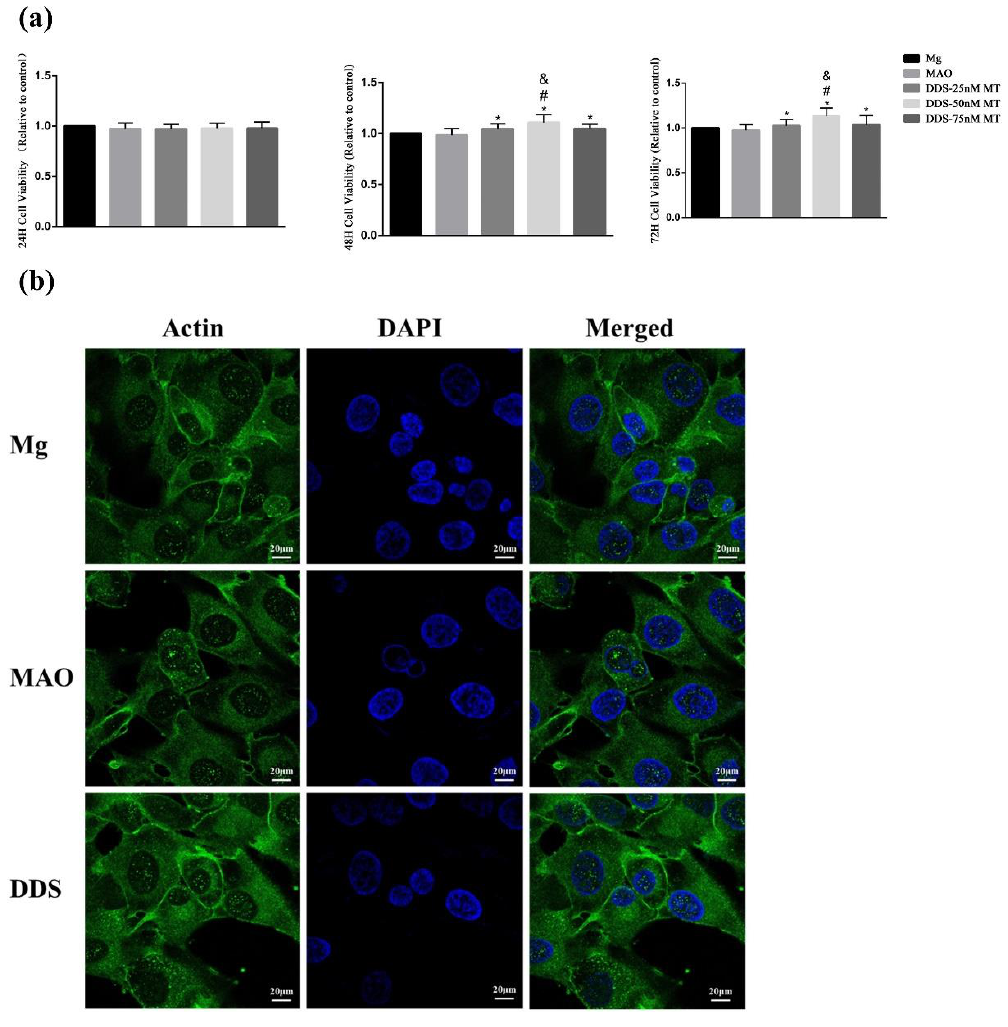
Figure 9. The cell viability of Mg alloy, Mg-based-MAO alloy, and Mg-based MAO-MT-PLGA DDS with three concentration gradients after co-culturing with the leaching solution for 24, 48, and 72 h. ( a ) and the cell adhesion and morphology ( b ) after co-culturing with the leaching solution for 24 h. “*” represents the DDS-50nM MT group compared with the control groups, “&” represents the DDS-50nM MT group compared with the DDS-75nM MT group, and “#” represents the DDS-50nM MT group compared with the DDS-25nM MT group.